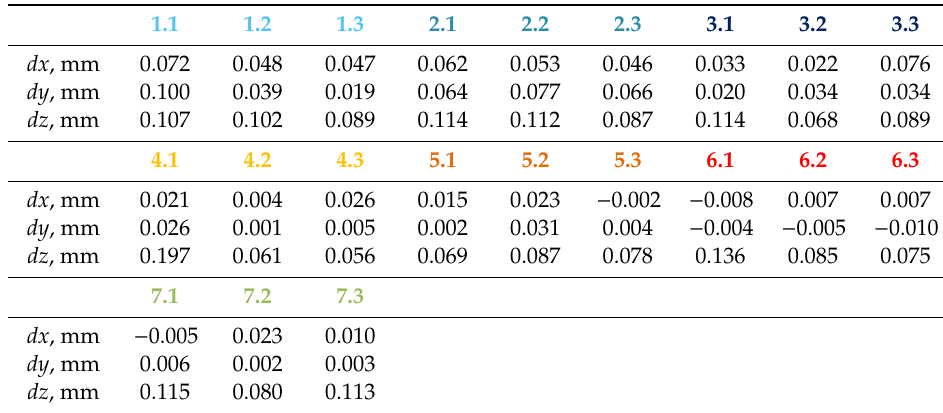
Table 2. Results of distance deviations in all three axes.